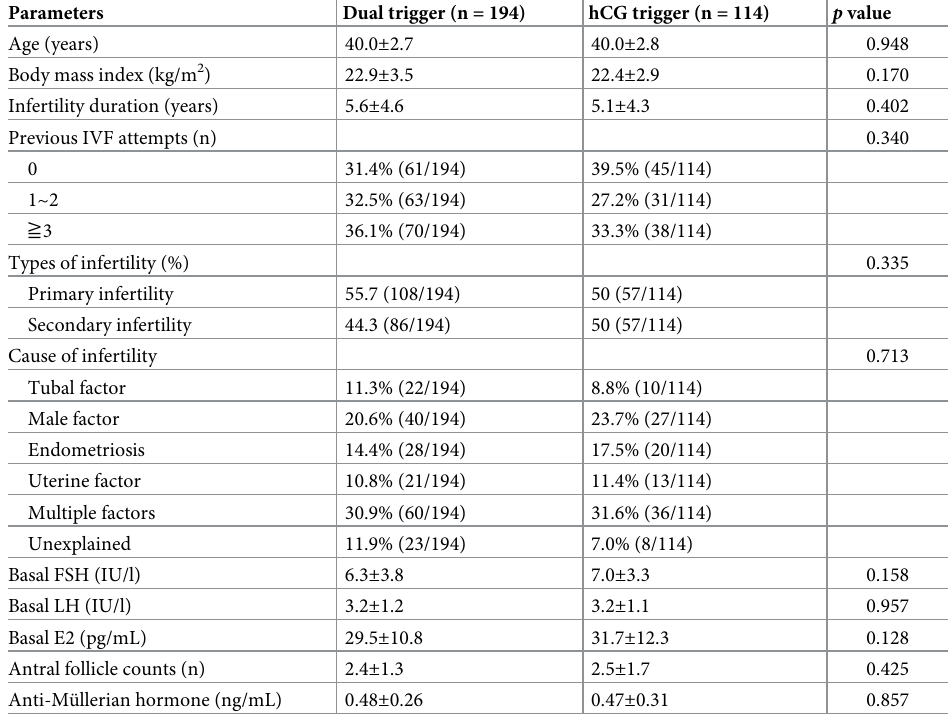
Table 1. Baseline characteristics of older patients with diminished ovarian reserve (POSEIDON group 4) with dual-trigger or hCG trigger.